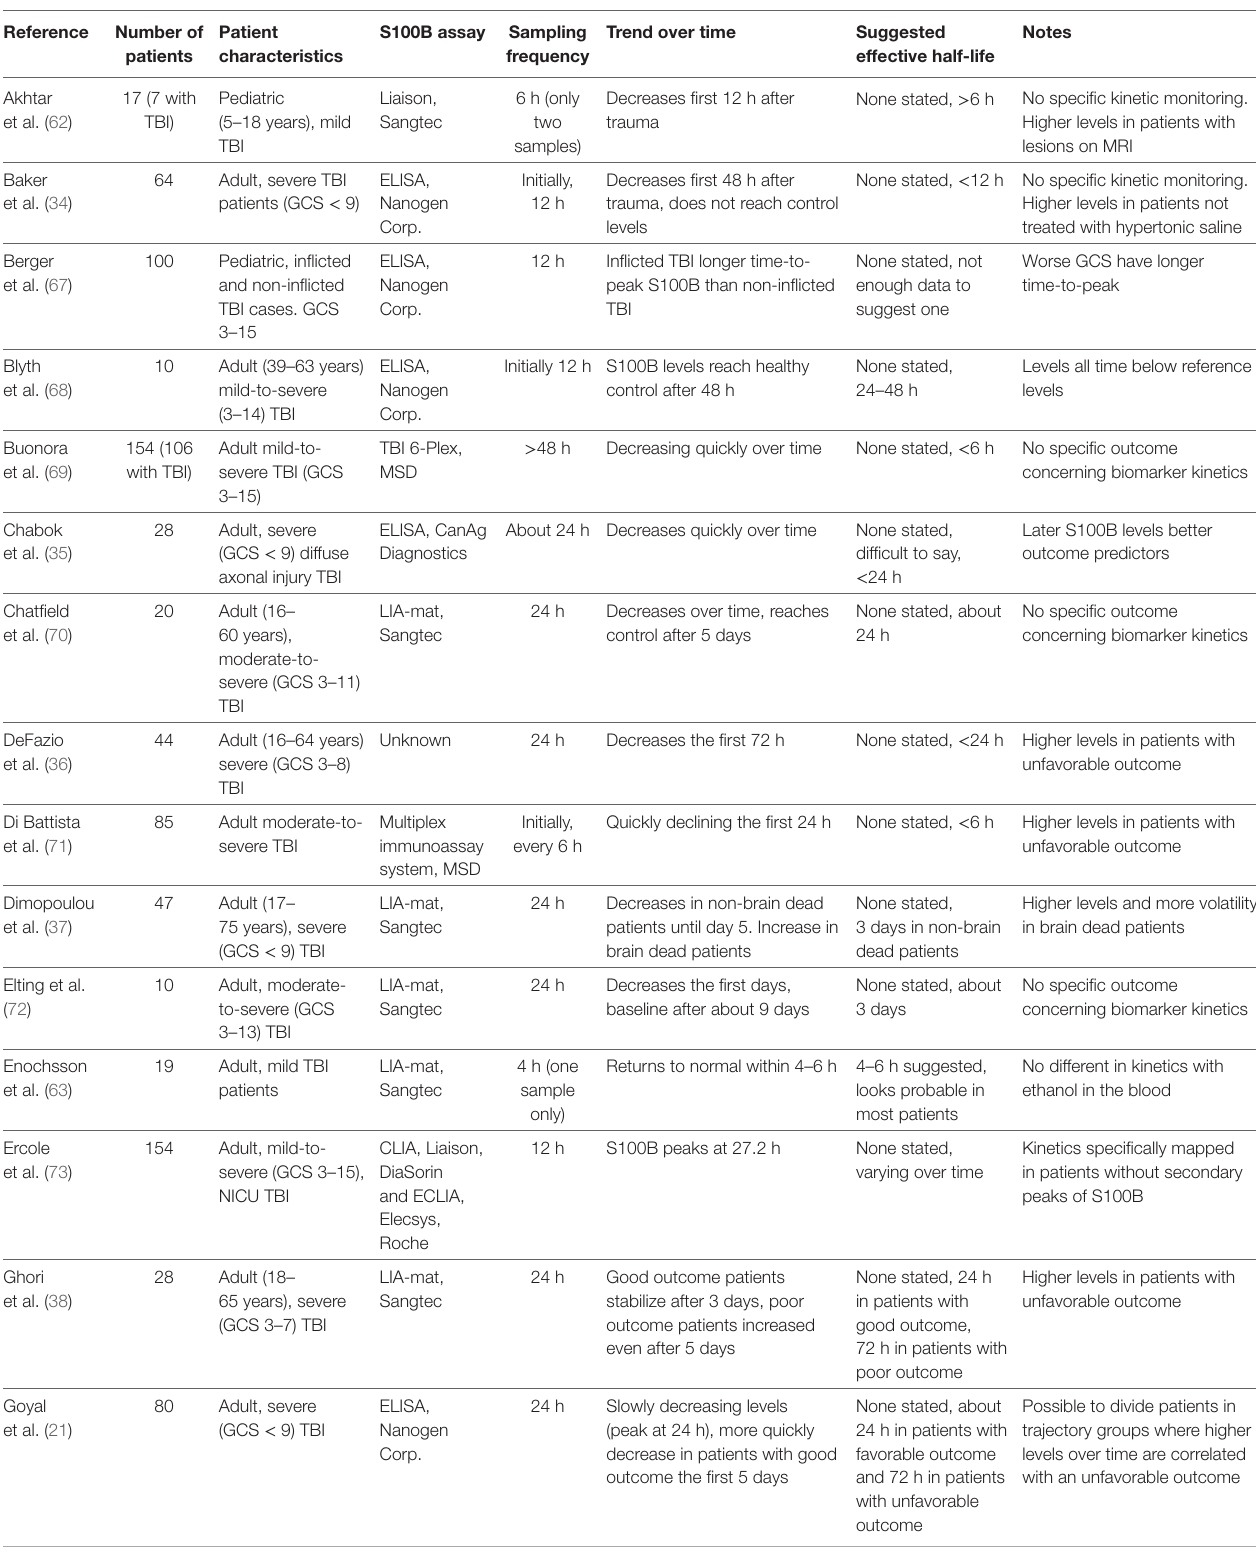
TABLe 1 | Analysis of S100B